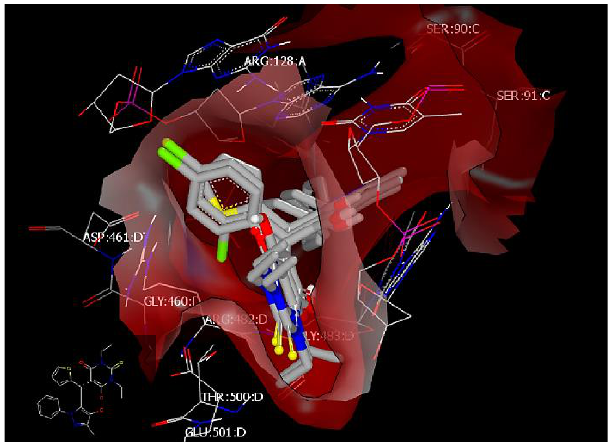
Figure 6. Visual representation of compounds 61c , 61o , and 61l docked with 5BTC, showing no hydrogen bond interaction, as shown by Vida. Image adapted from Elshaier et al. [65].